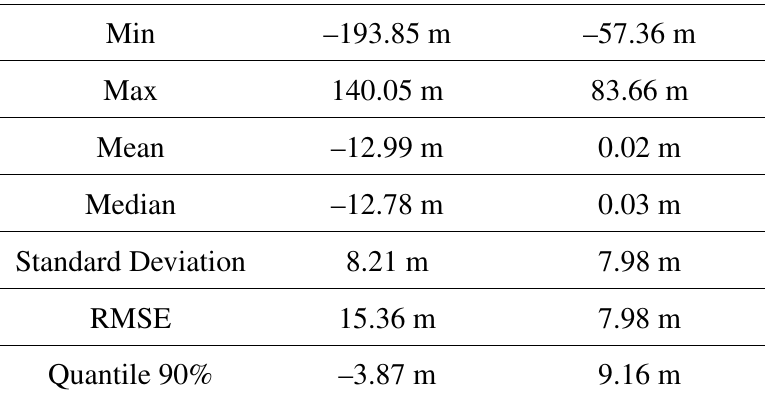
Table 2. Statistical parameters representing the quality improvement of the corrected ASTER GDEM. The ASTER GDEMs before and after correction is compared against the ICC ground